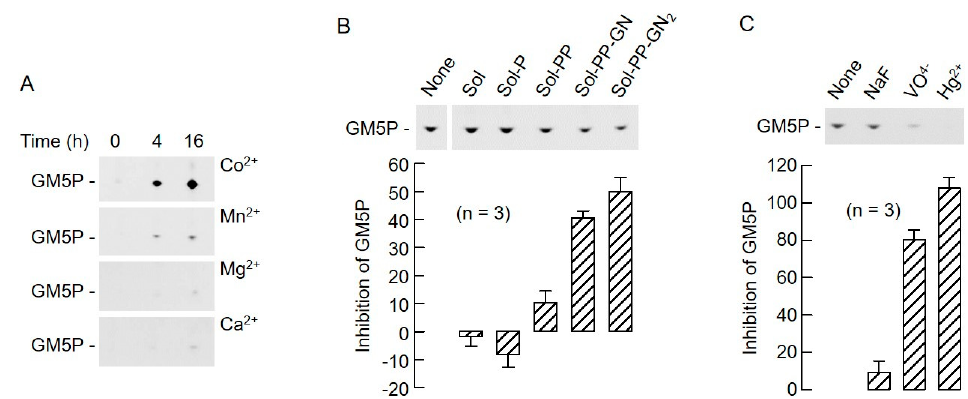
Figure 9. Biochemical profile of LII hydrolyzing activity. ( A ) Rat liver microsomes were solubilized in buffers containing 1 mM CoCl 2 (Co 2+ ), MnCl 2 (Mn 2+ ), MgCl 2 (Mg 2+ ), or CaCl 2 (Ca 2+ ). The extracts (20 µg) were incubated with 500 pmol LII(DAP)35 for the indicated times, and, after SPE, the 15 mM NH 4 OH eluates were dried down and analyzed by TLC. The migration position of GM5P is indicated to the left of the fluorograms. ( B ) LII(DAP)35 (500 pmol) was incubated with 27.2 µg of detergent-solubilized rat liver microsomal proteins in the presence of 2.5 nmol solanesol (Sol), solanesyl-P (Sol-P), solanesyl-PP (Sol-PP), solanesyl-PP-GlcNAc (Sol-PP-GN), or solanesyl-PP-GlcNAc 2 (Sol-PP-GN 2 ) for 4 h as described in Section 4. GM5P was quantitated as detailed above, and is expressed as a percentage of the quantity of GM5P generated in the absence of the solanesyl compounds (None). ( C ) Incubations were conducted exactly as described for (B) in the absence of additions (None) or presence of either 50 mM sodium fluoride (NaF), 5 mM sodium orthovanadate (VO 4 − ), or 1 mM mercury chloride (Hg 2+ ). GM5P was quantitated and expressed as for (B).